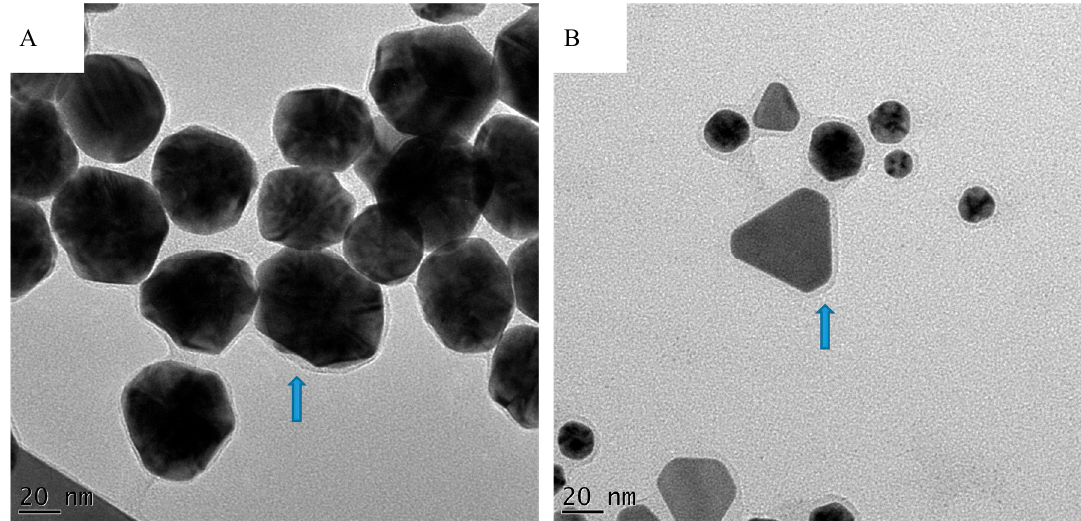
Figure 3. TEM images of AuNPs produced from ( A ) I. brachystachya and ( B ) A. rubicundus . The arrows point towards the halo surrounding the nanoparticles.